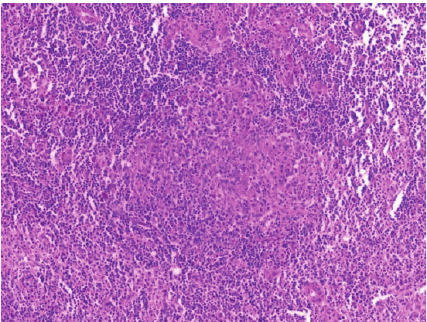
Figure4:Characteristicsuppurativegranulomasandstellatemicro- abscess formation (H and E, ×